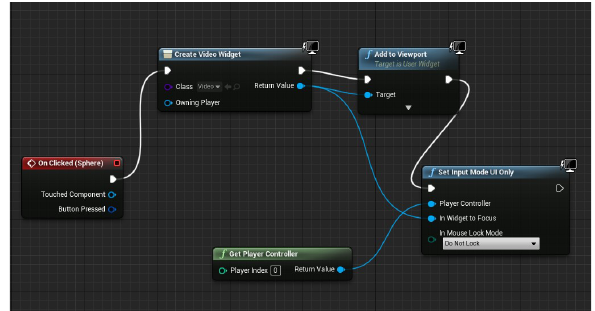
Figure 11. The Event Graph of Blueprint nodes for media and audio management